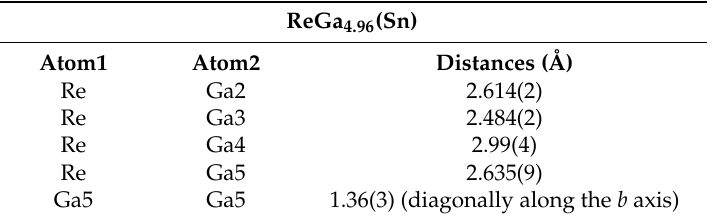
Table 3. List of atomic distances for ReGa 4.96 (Sn), ReGa 5.08 (Pb) and ReGa 5.13